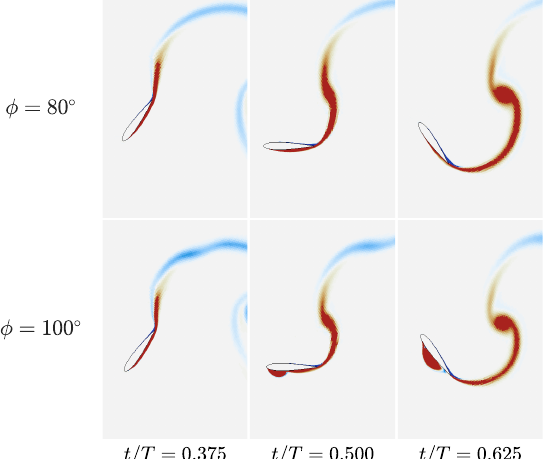
Figure 14. Normalized z-vorticity field during reversal for two motion phases at f ∗ = 0.18. Positive vorticity in red, negative vorticity in